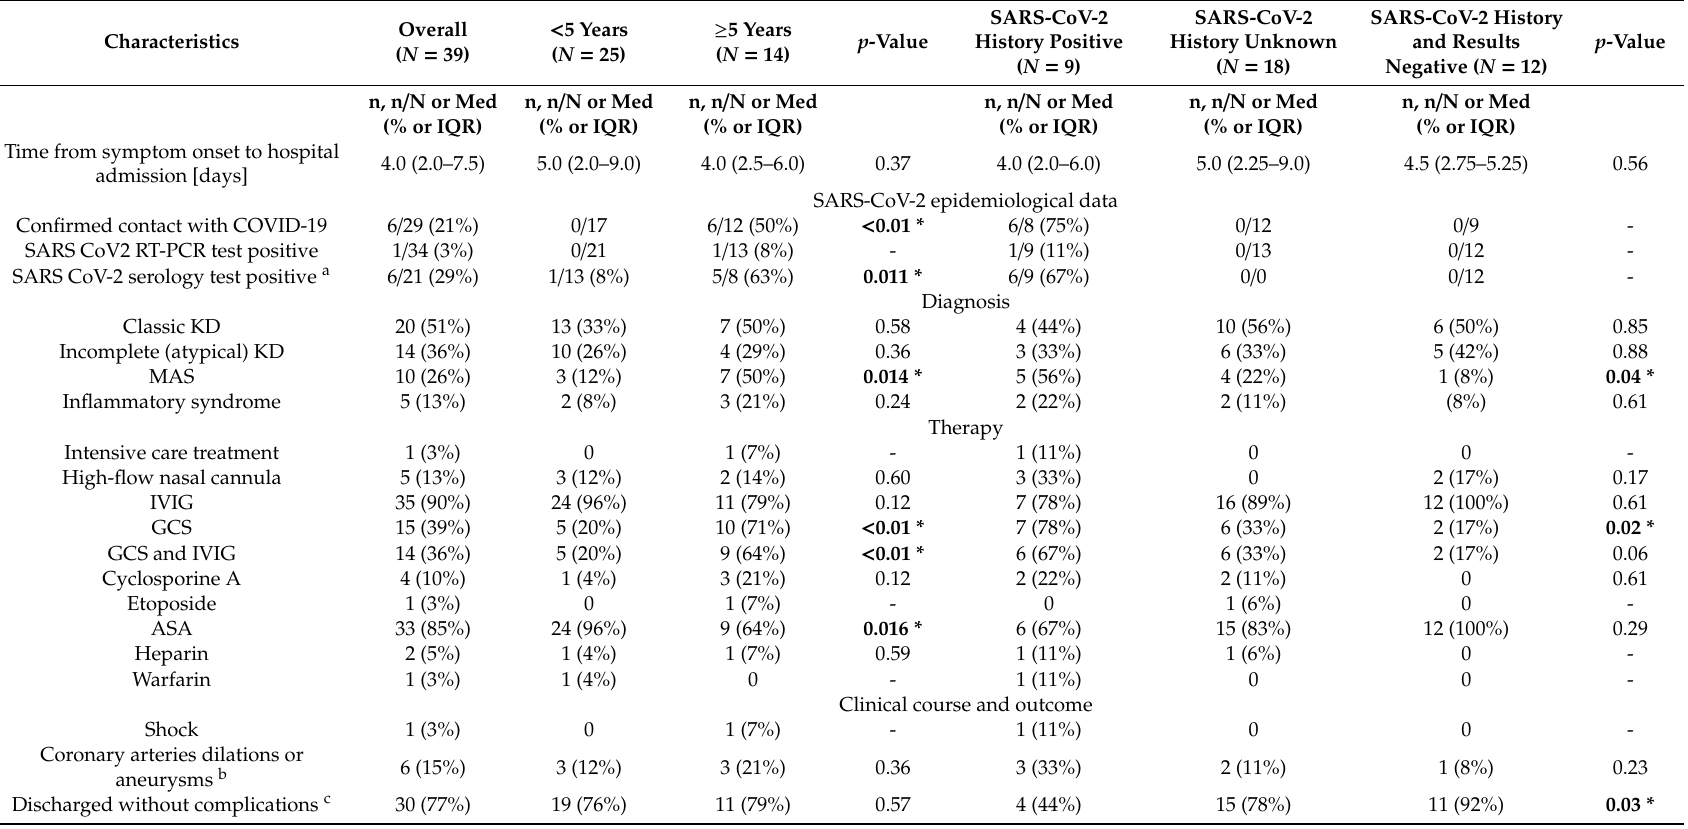
Table 3. Clinical course and outcomes, according to age group and SARS-CoV-2